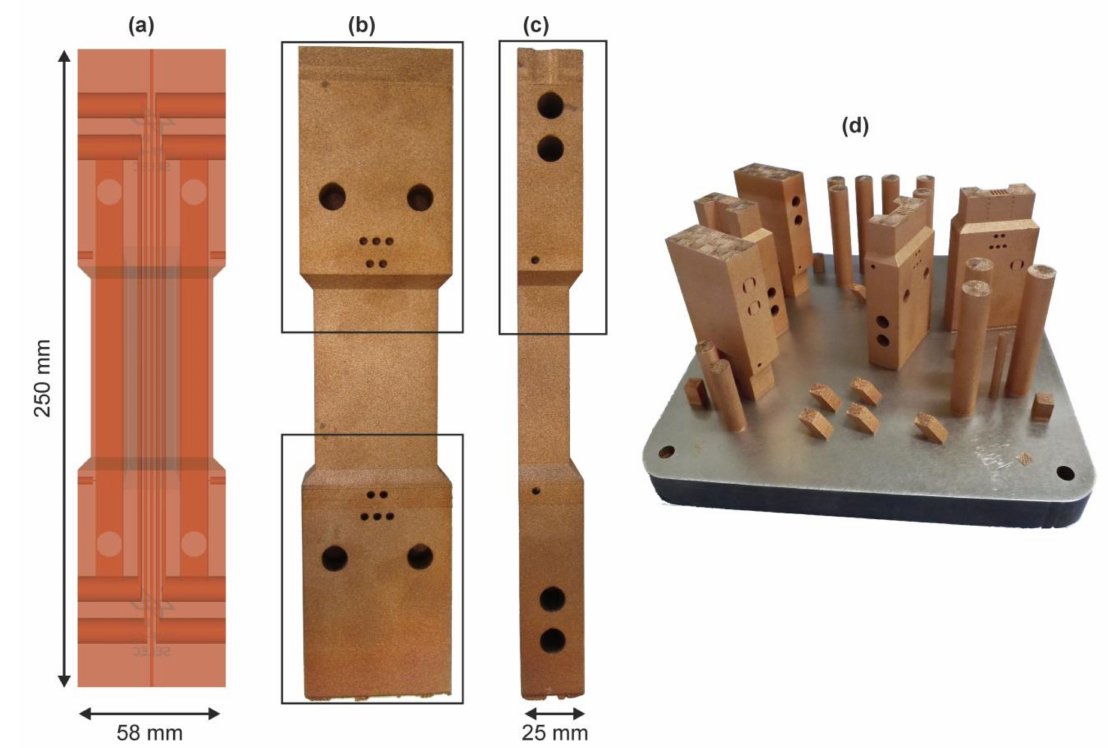
Figure 10. ( a ) Semi-transparent CAD model of a TMF-panel indicating the channels for internal cooling and instrumentation; ( b ) and ( c ) side views of a fabricated panel with top and bottom sections marked by boxes; ( d ) a build with geometrically di ffi cult top and bottom sections of these panels as well as numerous other